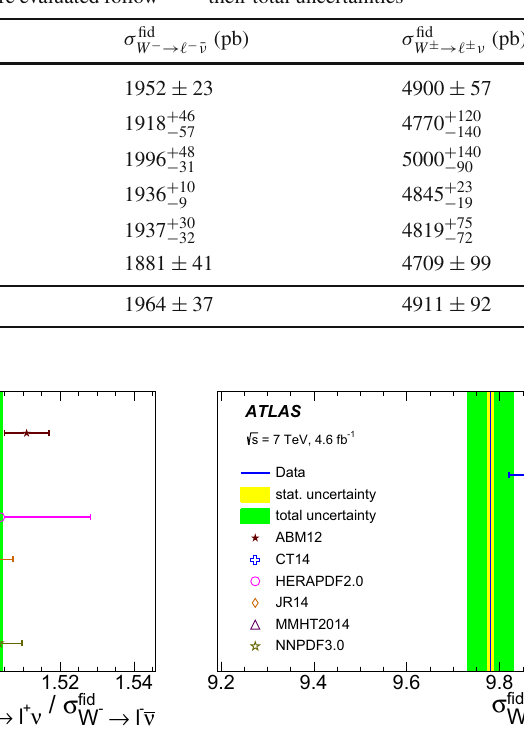
Table 16 Predictions at NNLO QCD and NLO EW as obtained with DYNNLO 1.5fortheintegratedfiducialcrosssections.Thegivenuncer- tainties correspond to PDF uncertainties only and are evaluated follow-